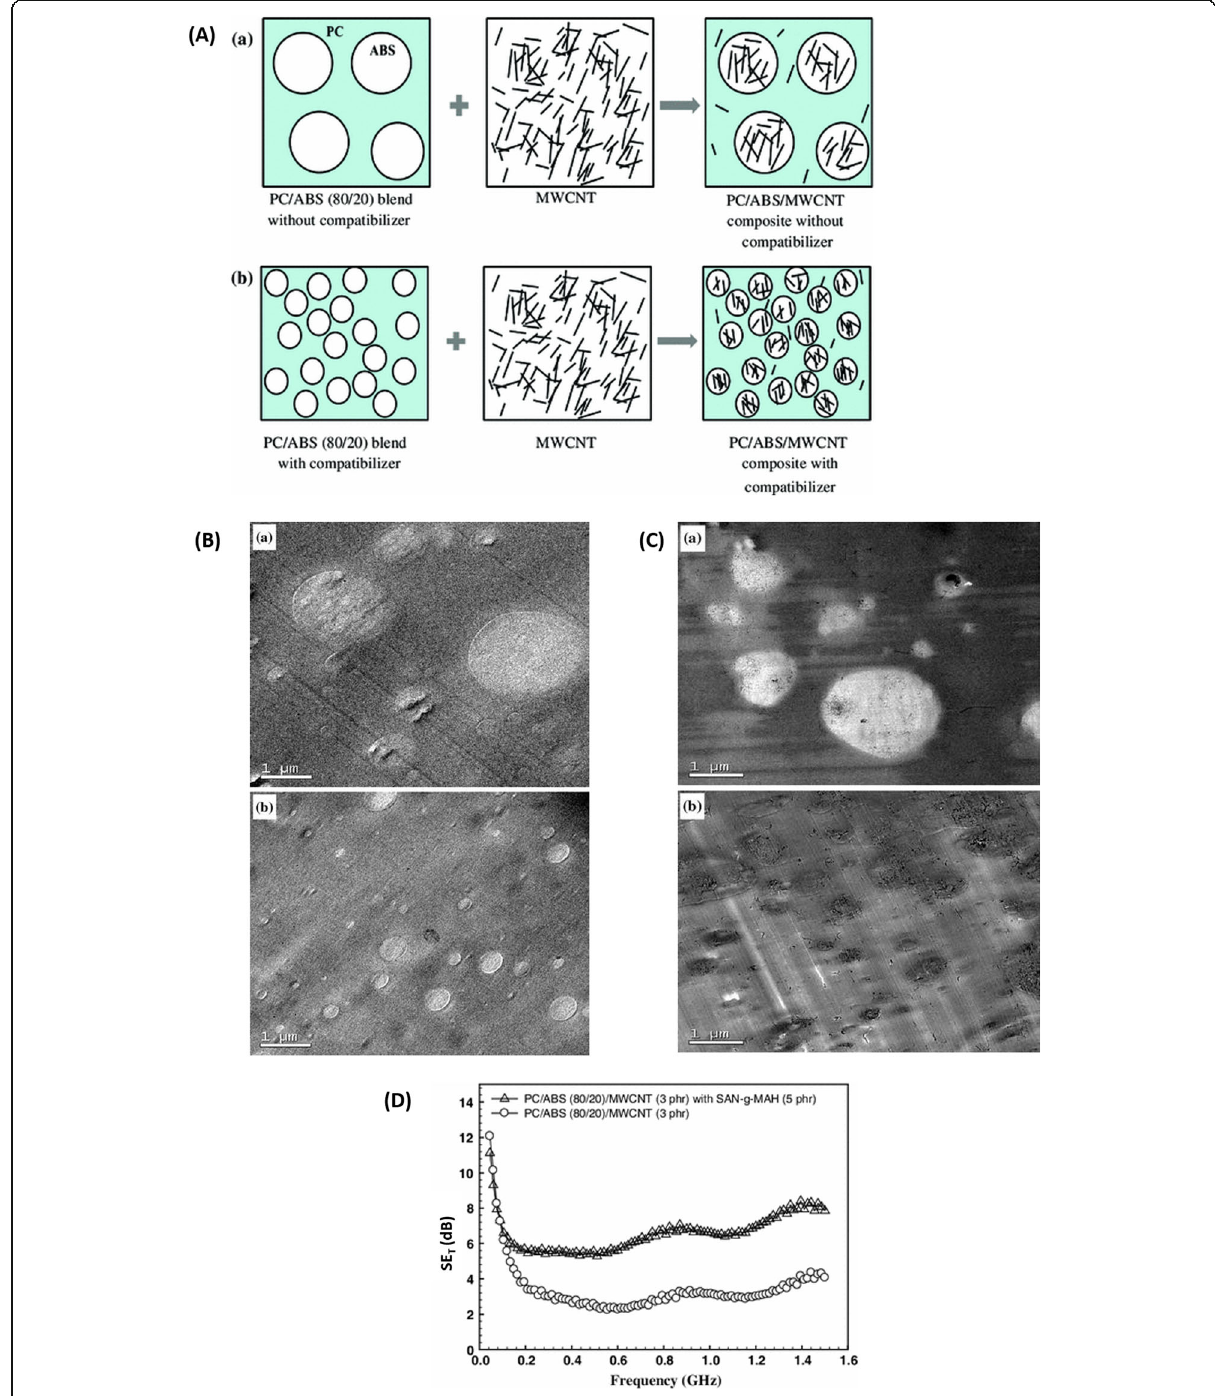
Fig. 13 (A) Schematic of PC/ABS with CNT (here labeled as MWCNT) as filler: ( a ) without compatibilizer, ( b ) with compatibilizer; ( B ) Transmission electron micrographs of ( a ) PC/ABS (80/20) blend, ( b ) PC/ABS (80/20) blend with compatibilizer (SAN-g-MAH, 5 phr); ( C ) Transmission electron micrographs of PC/ABS (80/20)/CNT (3 phr) composites: ( a ) without compatibilizer, ( b ) with compatibilizer (SAN-g-MAH, 5 phr); ( D ) SE T of the PC/ABS(80/20)/CNT (3 phr) composites with frequency: without compatibilizer and with compatibilizer (SAN-g-MAH, 5 phr). Reprinted with permission from Kim et al. [86], copyright 2014